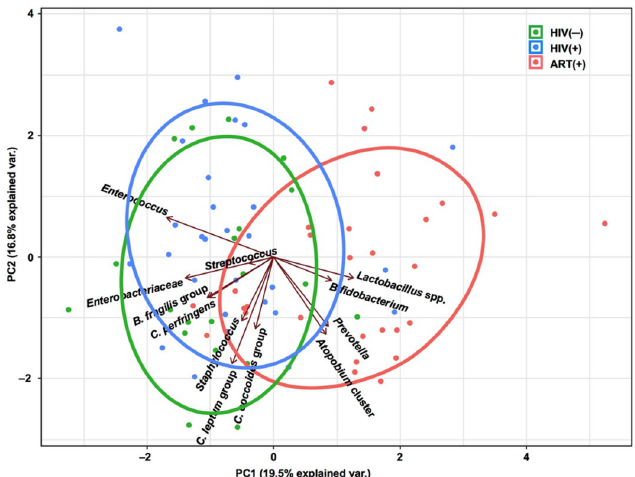
Fig 1. Principal component analysis based on the overall structure of the gut microbiota in three groups of children. Each data point represents an individual sample. Ellipses represent the 95% confidence level. Treatment groups are color-coded: green, HIV( − ); blue, HIV(+); and red, ART(+). Arrows indicate characteristic vectors of the 12 bacterial factors.